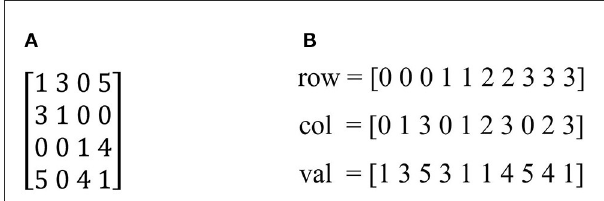
FIGURE3 The COO form of input matrix: (A) Input matrix. (B) The COO format of input matrix.